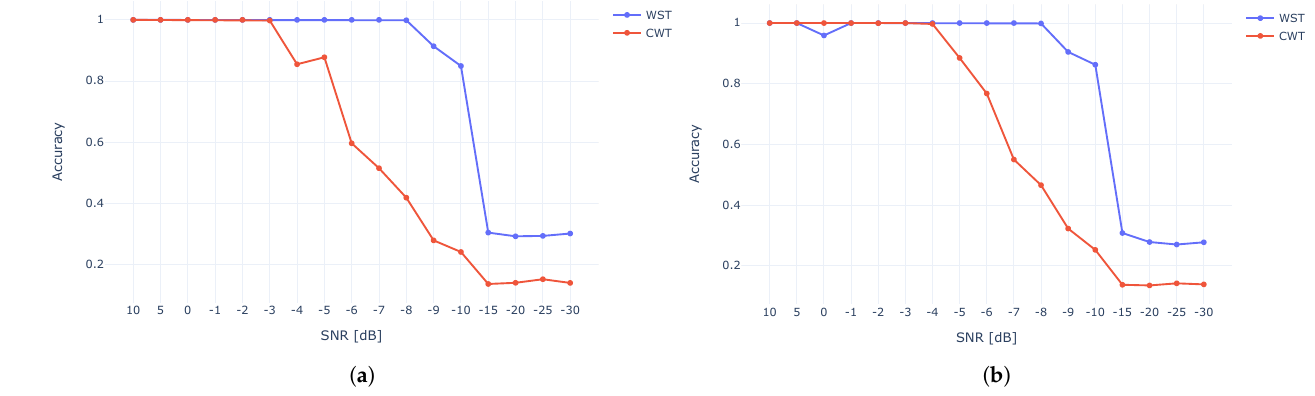
Figure 14. Clustering accuracy using t-SNE ( a ) and UMAP ( b ) for CWT and WST for different SNR.